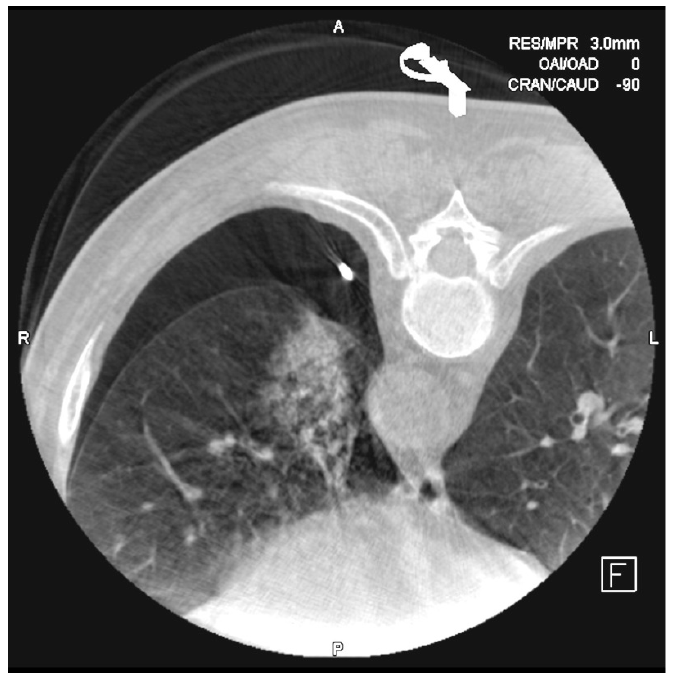
Figure 8. The most frequent complications after the biopsies are alveolar hemorrhage and pneumothorax. In this case, it was necessary to place a 6F drainage catheter for evacuating the air from the pleural